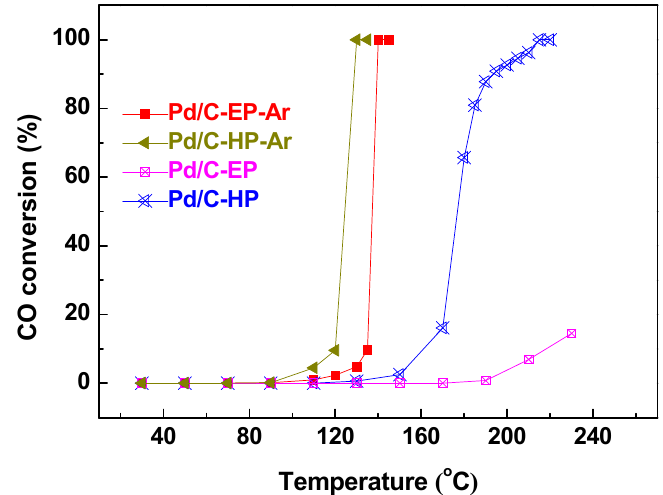
Figure 2. Catalytic activity of the catalytic materials Pd / C-EP-Ar, Pd / C-HP-Ar, Pd / C-EP, and Pd / C-HP for CO oxidation.